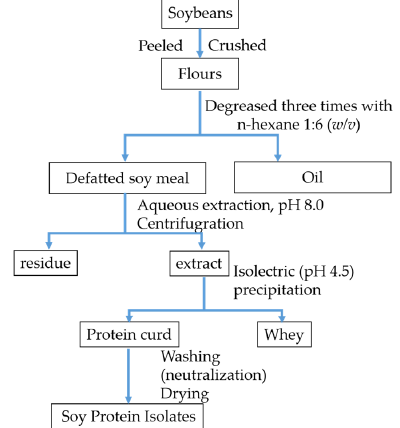
Figure 1. Flow chart of soybean protein isolate preparation.